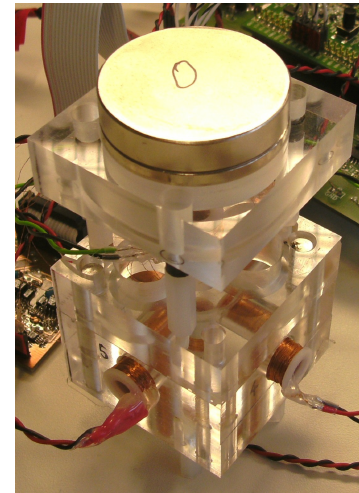
Figure 1. Photograph of the setup.